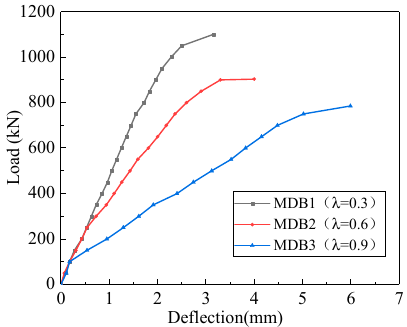
Figure 8. Relation curve between λ and deflection.